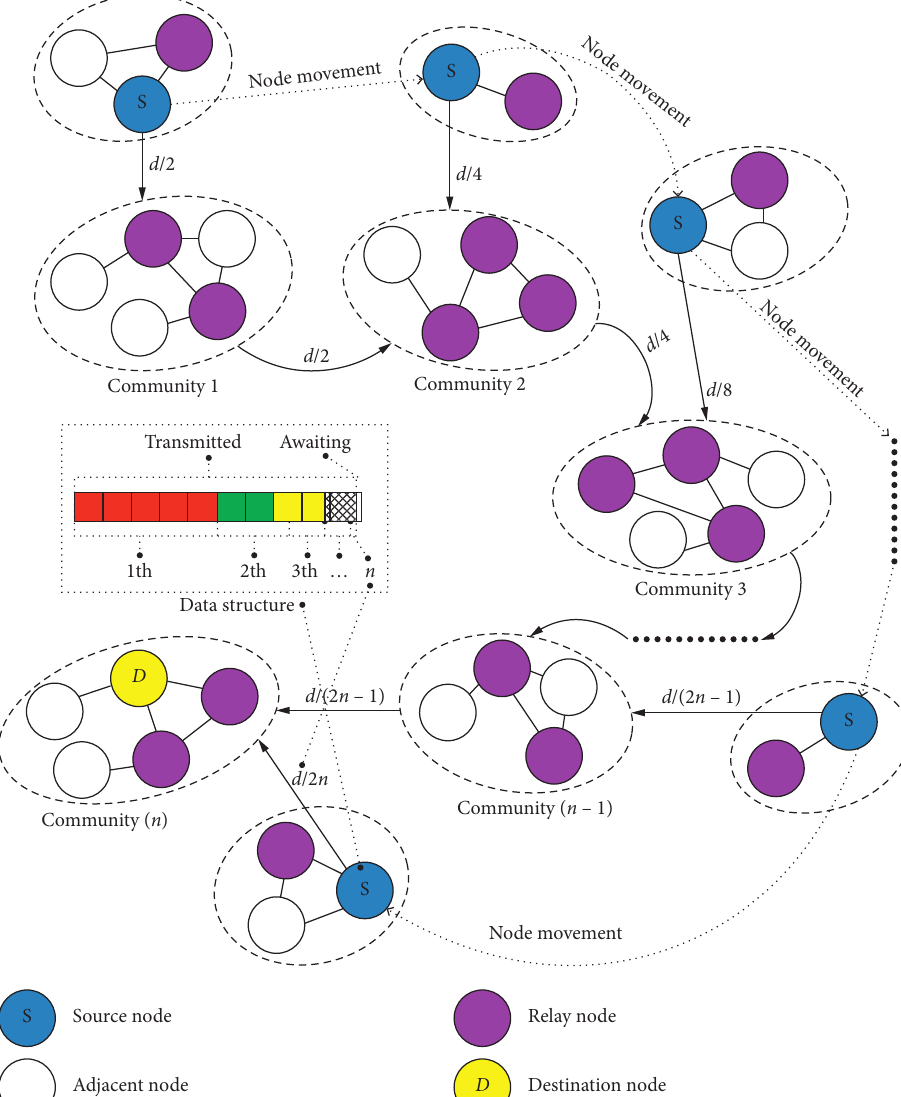
Figure 6: Process of the source node deliver information and data structure in n -time